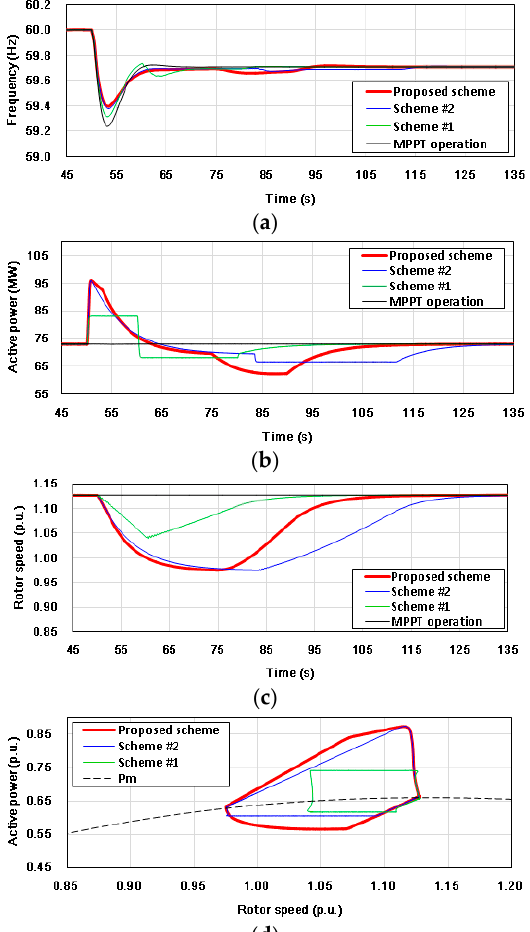
Figure 6. Results for Case 1. ( a ) system frequencies; ( b ) WPP outputs; ( c ) Rotor speeds; ( d ) Power-speed